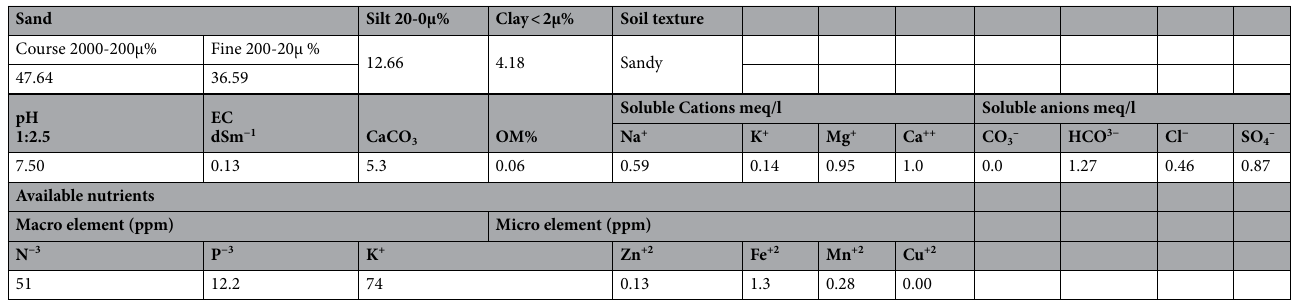
Table 7. Mechanical and chemical analysis of the experimental site